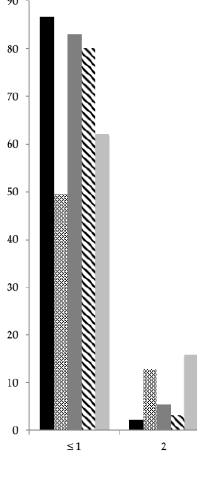
Figure 2. Susceptibility to C/T of clinical isolates of Enterobacterales in five Latin American countries between 2016 and 2017 in relation to the minimum inhibitory concentration (MIC) to C/T. Each bar represents one of the five countries evaluated.